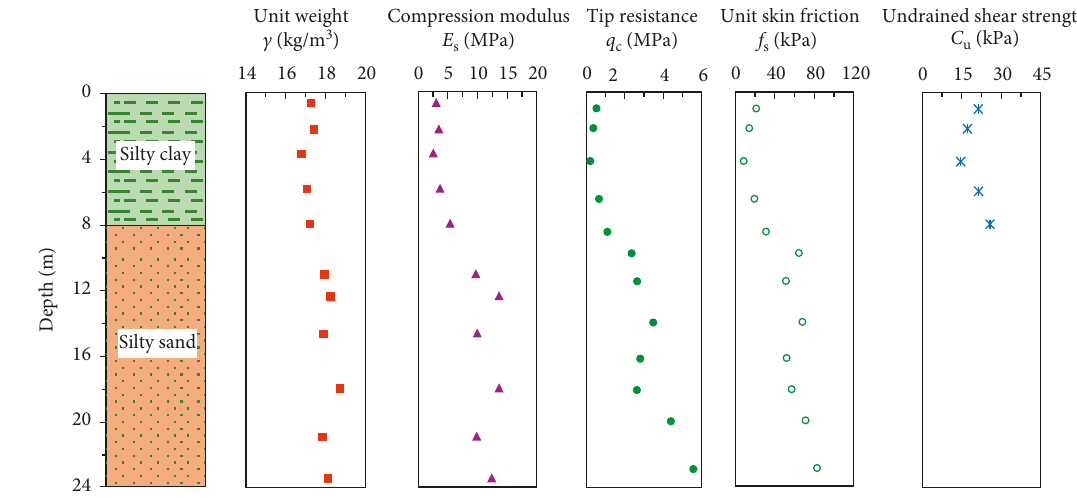
Figure 2: Soil profile and engineering properties of the test Table 1: Detailed information about test piles (PCI-1 and PC-1).